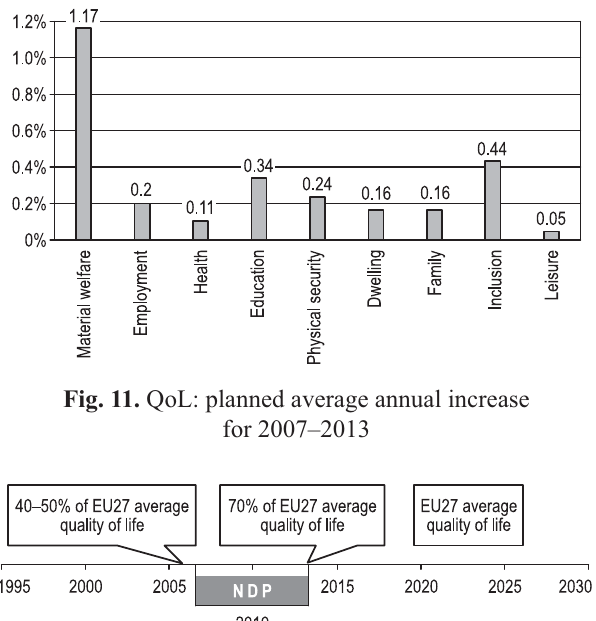
Fig. 12. Estimation of the QoL: Latvia and the EU